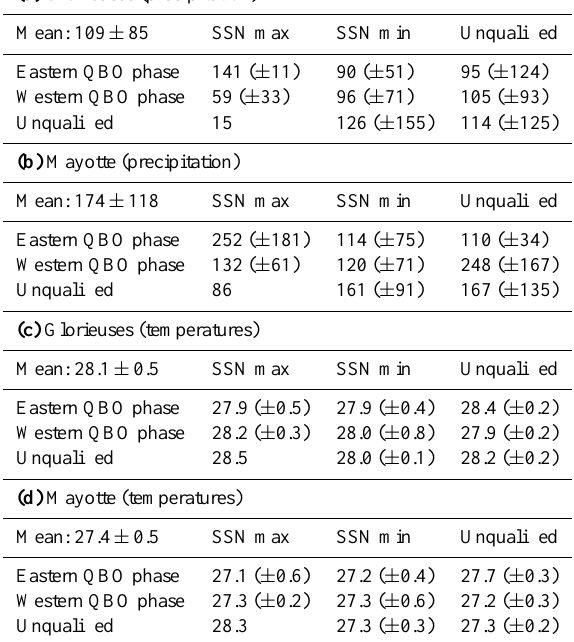
Table 5. Mean and SD of precipitation (mmmonth − 1 ) in December for (a) the Glorieuses and (b) Mayotte during the different phases of QBO and SSN, and mean and SD of temperature ( ◦ C) for (c) the Glorieuses and (d) Mayotte during the different phases of QBO and SSN.